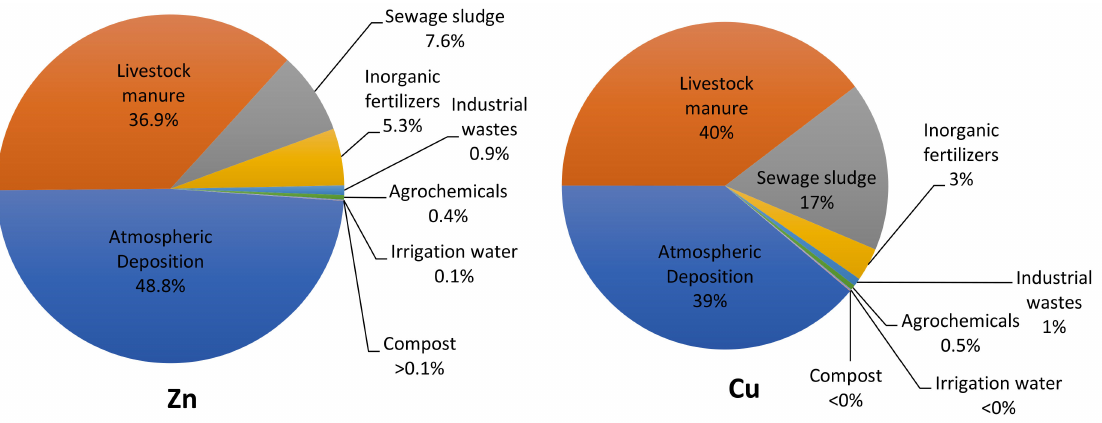
Figure 1. Sources of Cu and Zn on agriculture lands. Industrial waste includes food waste, compost, and waste from paper and textile